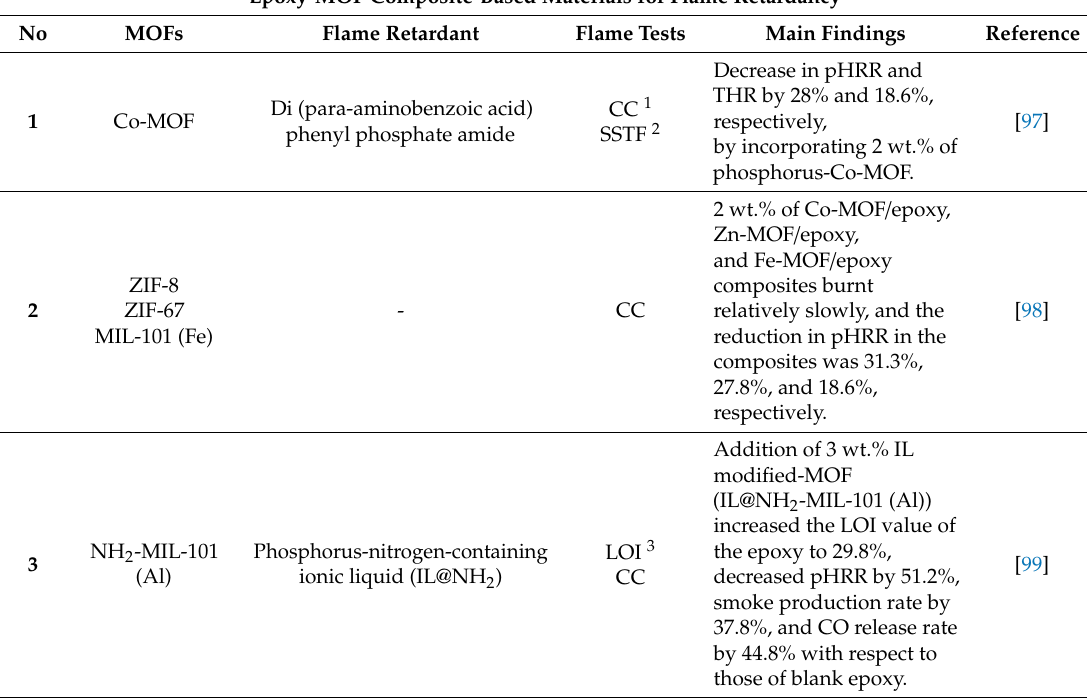
Table 2. Epoxy / MOF nanocomposites applied in the FR systems. The main outcomes of recent research are also provided. Di ff erent types of MOFs are collected in the following table, such as ZIF-67; NH2-MIL101 (Al), Co-MOF [95] and MIL-101 (Fe) [96] are made of Zn (II), Al (III) and Fe (III)